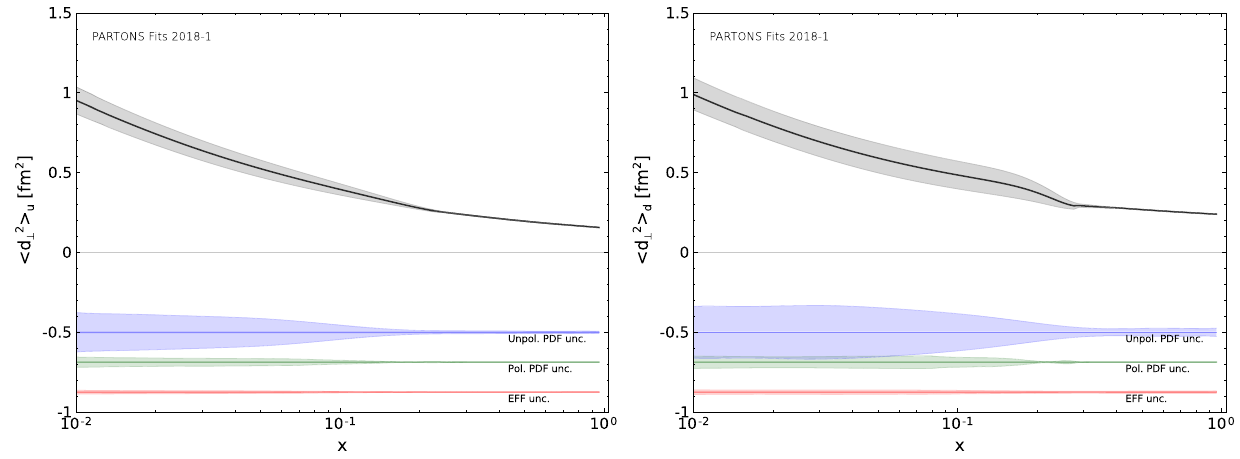
Fig. 18 Mean distance between the active quark and the spectator system for up (left) and down (right) quarks as a function of the longitudinal momentum fraction x . For further description see Fig. 6